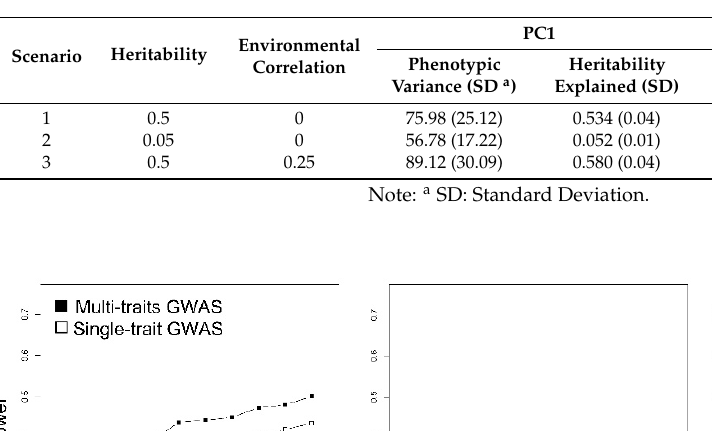
Table 2. Phenotypic variance and heritability explained by each principle component.